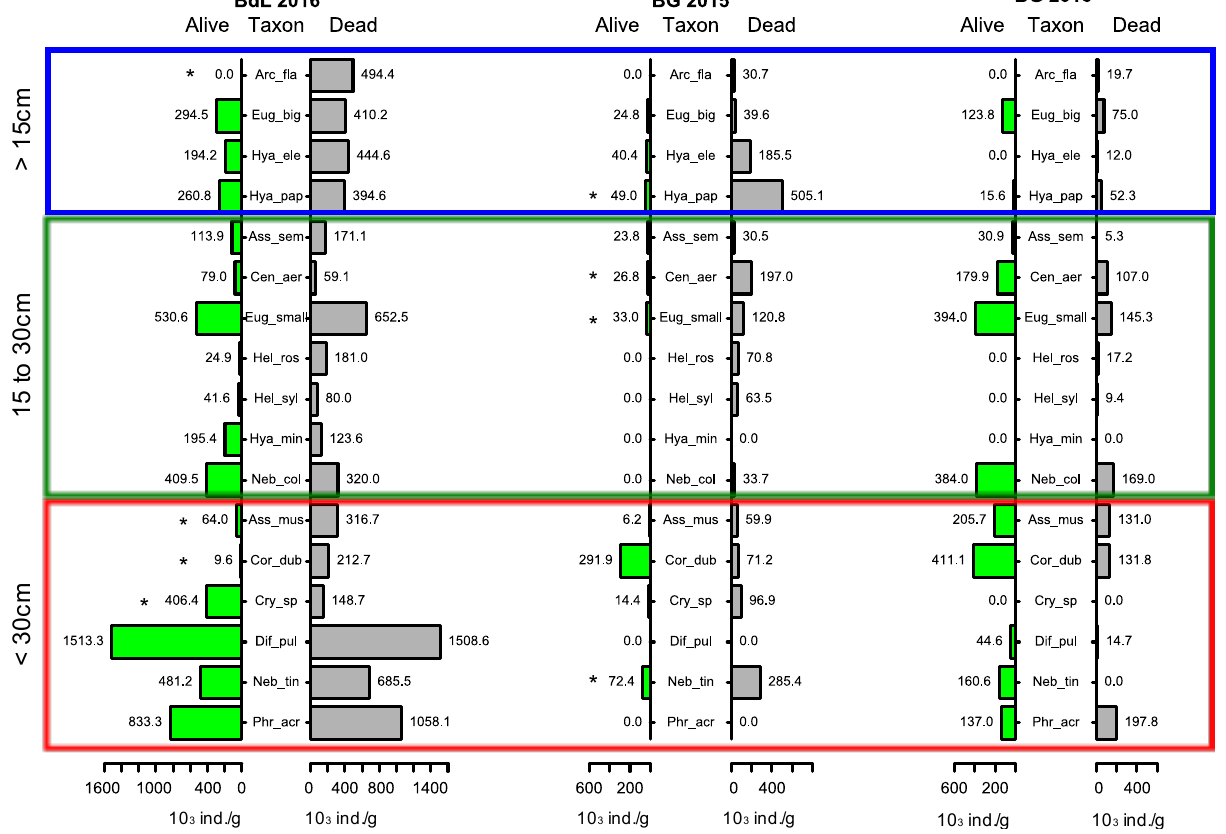
Figure 4. Density of testate amoeba taxa in the Neuchâtel Botanic Garden experimental peatland (BG 2015, BG 2016) and the Bois-des-Lattes reference peatland (BdL). For each dataset, the density of each morphotaxon is split between living (left, green) and dead (right, grey). The morphotaxa are arranged in three groups according to their water table depth optima: < 15 cm (top frame), 15–30 cm (middle frame), > 30 cm (bottom frame). Stars indicate significant differences in density between living and dead populations within the communities (Wilcoxon rank sum test p-value < 0.05). Morphotaxa